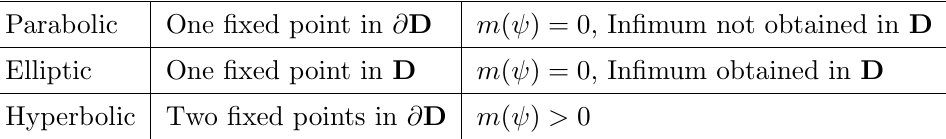
Table 1 . The types of automorphysms of the Poincar(cid:19)e disk related to the (cid:12)xed points and the